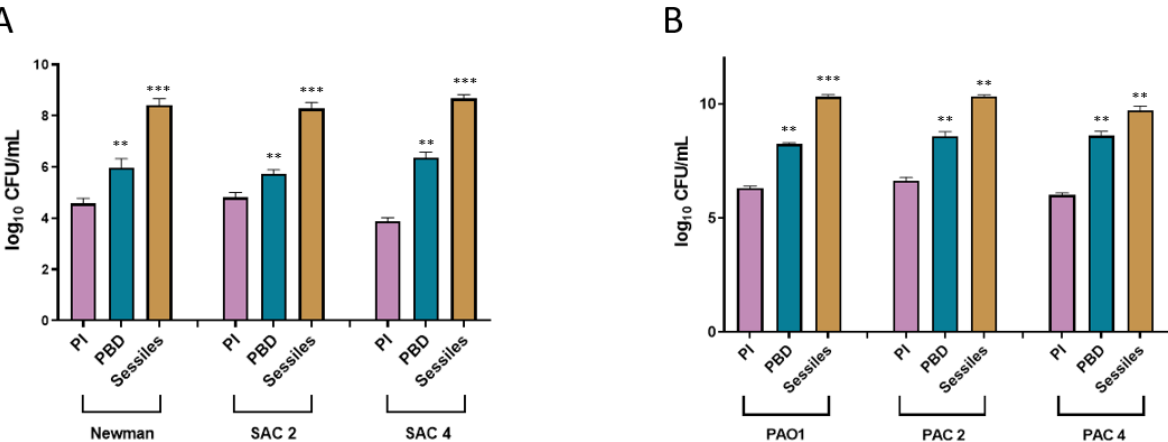
Figure 4. Quantification of biofilm formation of planktonic initial (pink), planktonic biofilm-detached (blue), and sessile (yellow) S. aureus ( A ) and P. aeruginosa ( B ) cultivated alone in CWM inside the open microfluidic system BioFlux TM 200. The mature biofilm biomass was evaluated after 24-h incubation. Samples were tested in triplicate in two independent experiments. Results are presented as the mean ± standard deviation of three different experiments. Statistics were performed using a t -test on GraphPad Prism version 9.2 to compare planktonic released and sessile cells compared to planktonic initial bacteria. ** p < 0.01; *** p < 0.001.